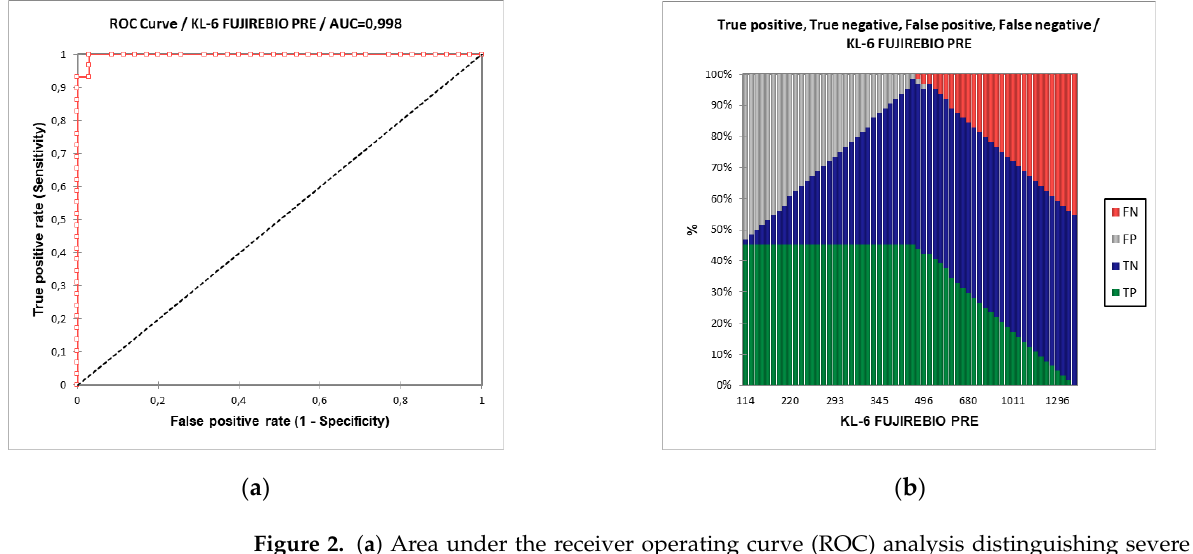
Figure 2. ( a ) Area under the receiver operating curve (ROC) analysis distinguishing severe and non-severe patients according to T0 KL-6 concentrations detected by Lumipulse G600II. ( b ) The percentages of the false negative, true negative, false positive and true positive patients for the KL-6 concentrations at T0 detected by Fujirebio reagent.